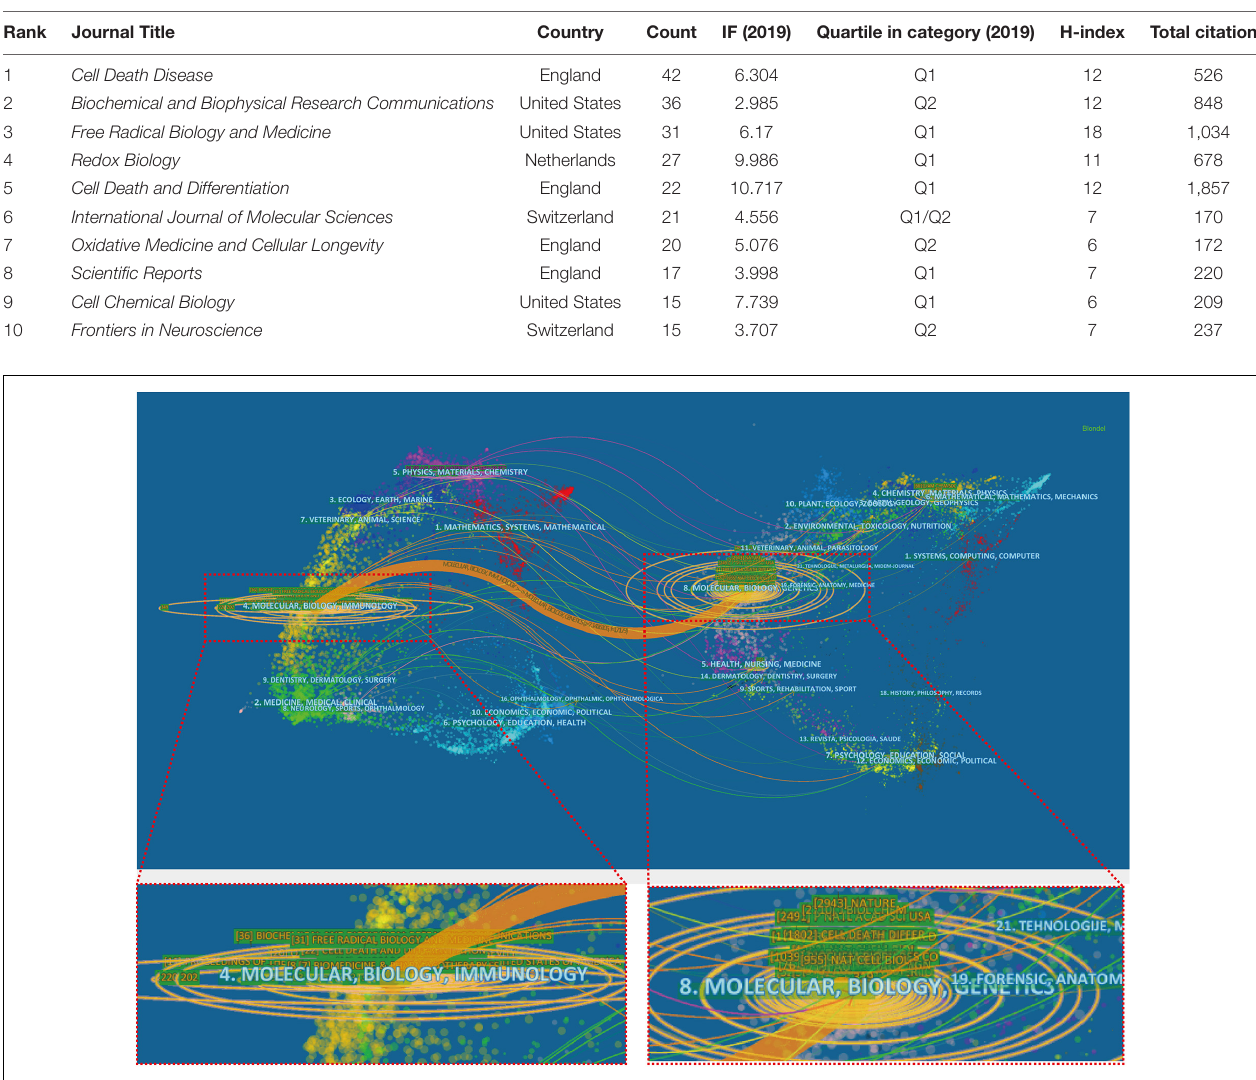
TABLE 4 | The top 10 journals of ferroptosis research ranked by publication number.